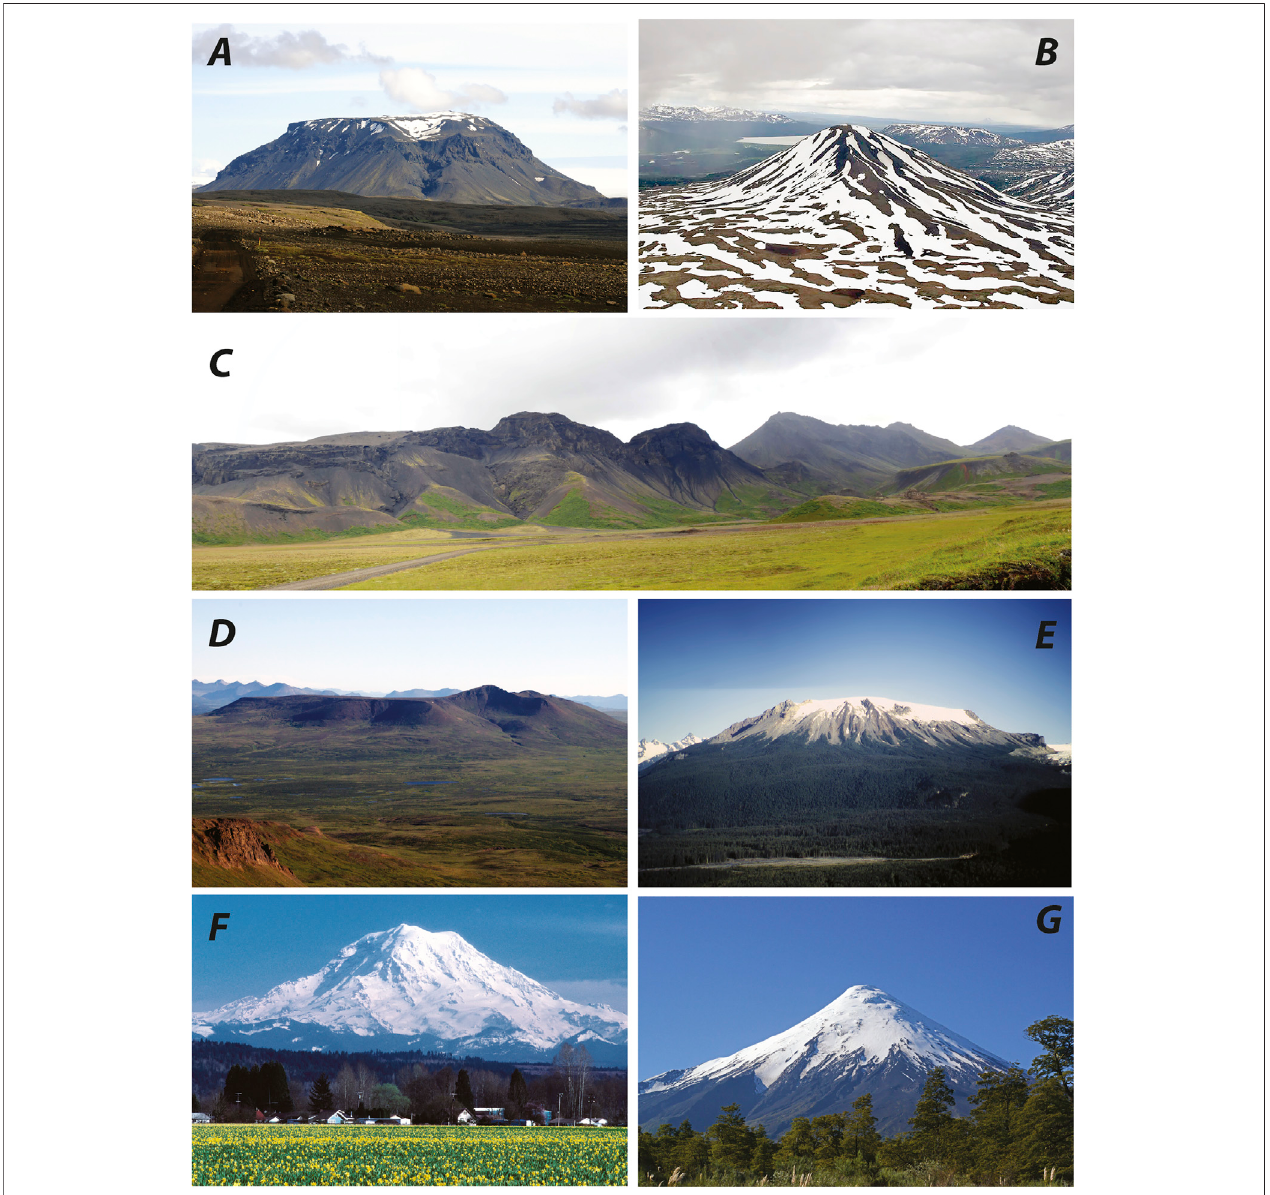
FIGURE 4 | Volcano morphologies diagnostic of cryospheric eruption environments. (A) Hlödufell, a fl at-topped, basaltic tuya in the Western Volcanic Zone, Iceland. (B) South tuya, a conical, basaltic tuya in the Tuya area, British Columbia, Canada. (C) Kalfstindar, a basaltic tindar (a.k.a. linear tuya) in the Western Volcanic Zone, Iceland. (D) Kima ’ Kho tuya, a compound, basaltic tuya on the Kawdy Plateau, British Columbia, Canada. (E) Hoodoo Mountain, a long-lived trachyte-phonolite tuya/stratovolcano, Coast Mountains, British Columbia, Canada. (F) Mount Rainier, an andesitic stratovolcano in the Cascade volcanic arc, Washington State, U.S.A. (Image courtesy of U.S.G.S. Cascade Volcano Observatory). (G) Osorno volcano, a basaltic stratovolcano in the Southern Andean Volcanic Zone, Chile. Unless speci fi cally noted, all images in this and subsequent fi gures were taken by B.